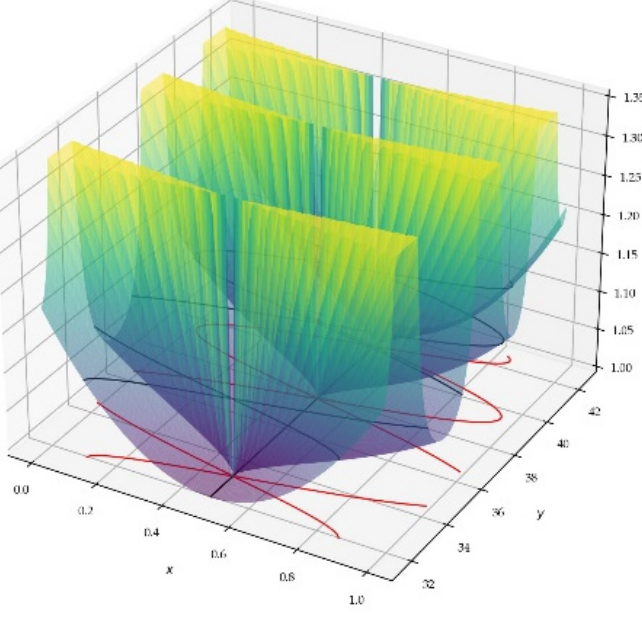
. . x 2 + i b x 3 . On this 3D